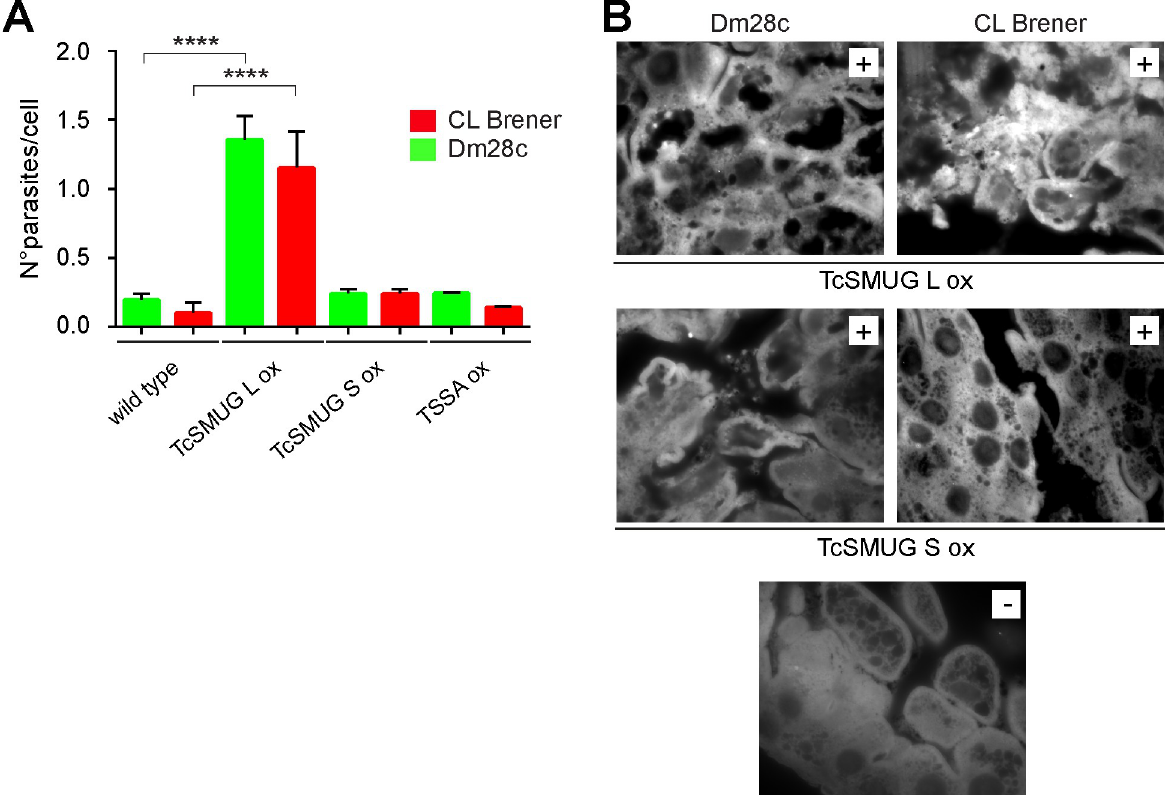
Fig 3. Binding of T . cruzi TcSMUG L products to T . infestans midgut tissues. A) Midgut tissues obtained from T . infestans fifth-instar nymphs 12–15 days after the last bloodmeal were incubated with 2 x 10 3 epimastigotes from the indicated line and the number of adhered epimastigotes per 100 epithelial cells were counted in 10 different fields of each tissue preparation. For each experimental group, 10 insects were used and experiments were performed in triplicate. Data are expressed as mean ± S.D. and asterisks denoted significant differences between the population means ( P < 0.0001) assessed by ANOVA and Tukey’s tests. B) Confocal laser microscopy of the inner surface of T . infestans midguts incubated with total lysates from the indicated transgenic line, followed by mAb anti-FLAG-based indirect immunofluorescence assay. A control staining of the anti-FLAG mAb in the absence of parasite lysate is shown